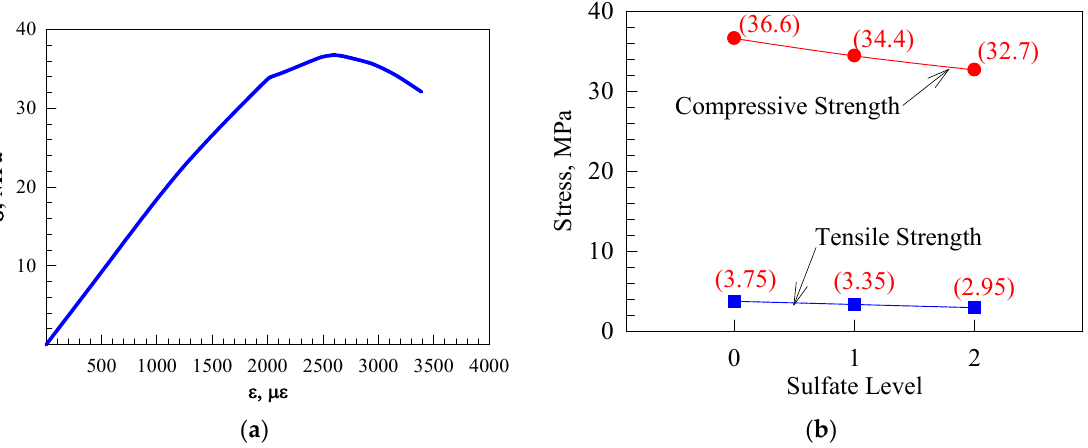
Figure 3. Concrete: ( a ) stress–strain curve [32] and ( b ) mechanical damaged subjected-to-sulfate attack. Adapted from Al-Rousan et al. [31].